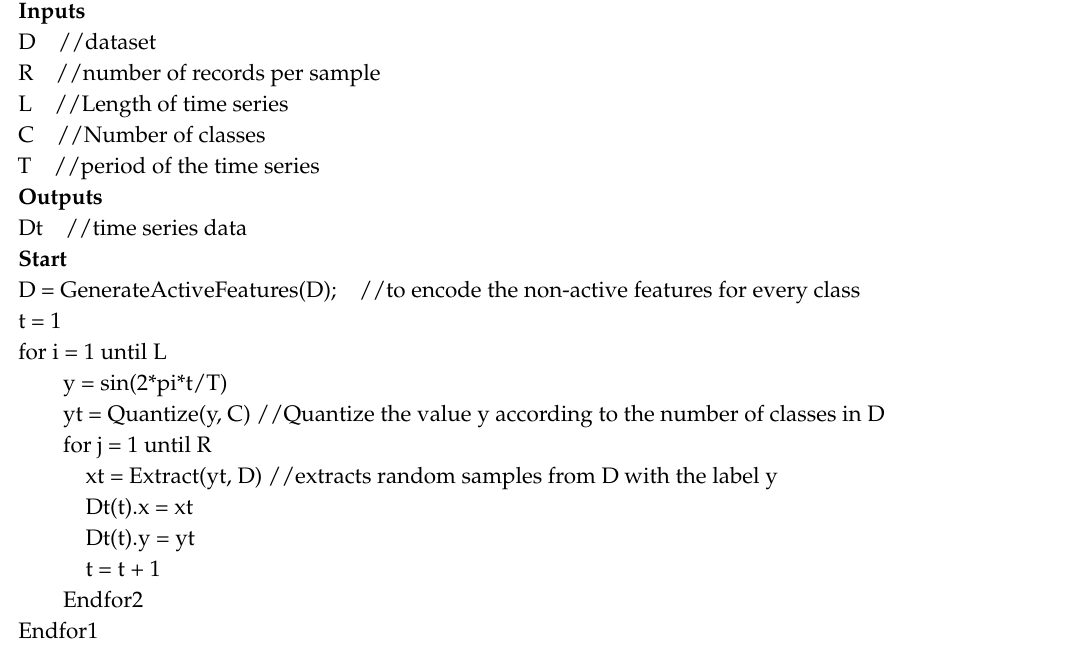
Algorithm 1. Pseudocode for converting a dataset into cyclic dynamic with a feature-adaptive time